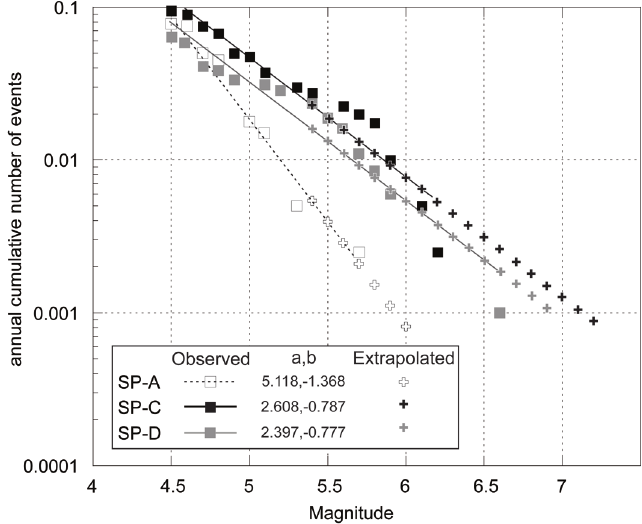
Figure 4. Earthquake rates assigned to the three SPs (SP-A, SP-C and SP- D) where the homogeneously distributed seismicity was modeled. The observed rates came from the CPTI04 historical catalog [CPTI Working Group 2004] for M > 5.5, and from the CSTI instrumental catalog [CSTI were converted into M as explained in Working Group 2001] below. M L w the main text. The extrapolated rates (crosses) are the G-R relationships obtained using the least-squares method on magnitude bins of 0.1, from the lower bound at M = 5.4 to the upper bound corresponding approximately to 0.001 earthquakes/year inside the whole of the